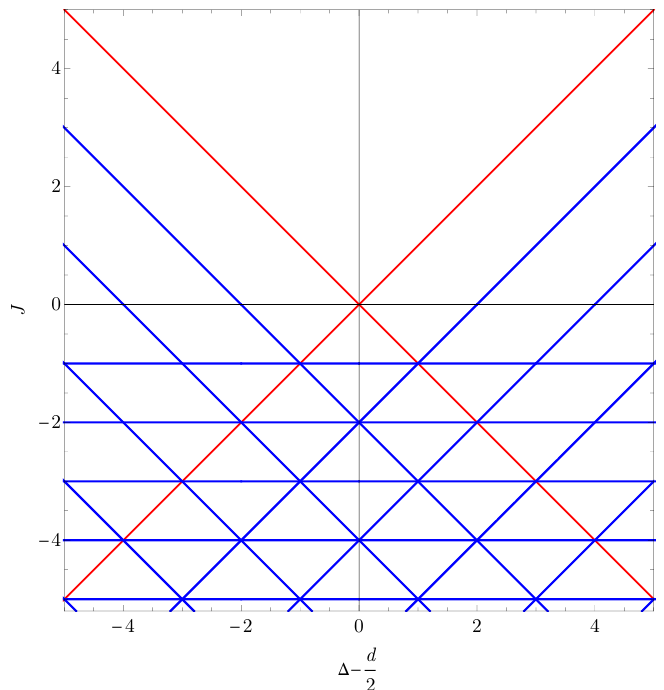
Figure 9. The expected structure of the perturbative ( Z 2 -even, parity-even, traceless-symmetric) Regge trajectories in Wilson-Fisher theory. All the Regge trajectories (blue) except the leading trajectory (red) have degeneracies, which are expected to be broken at sufficiently high orders of perturbation